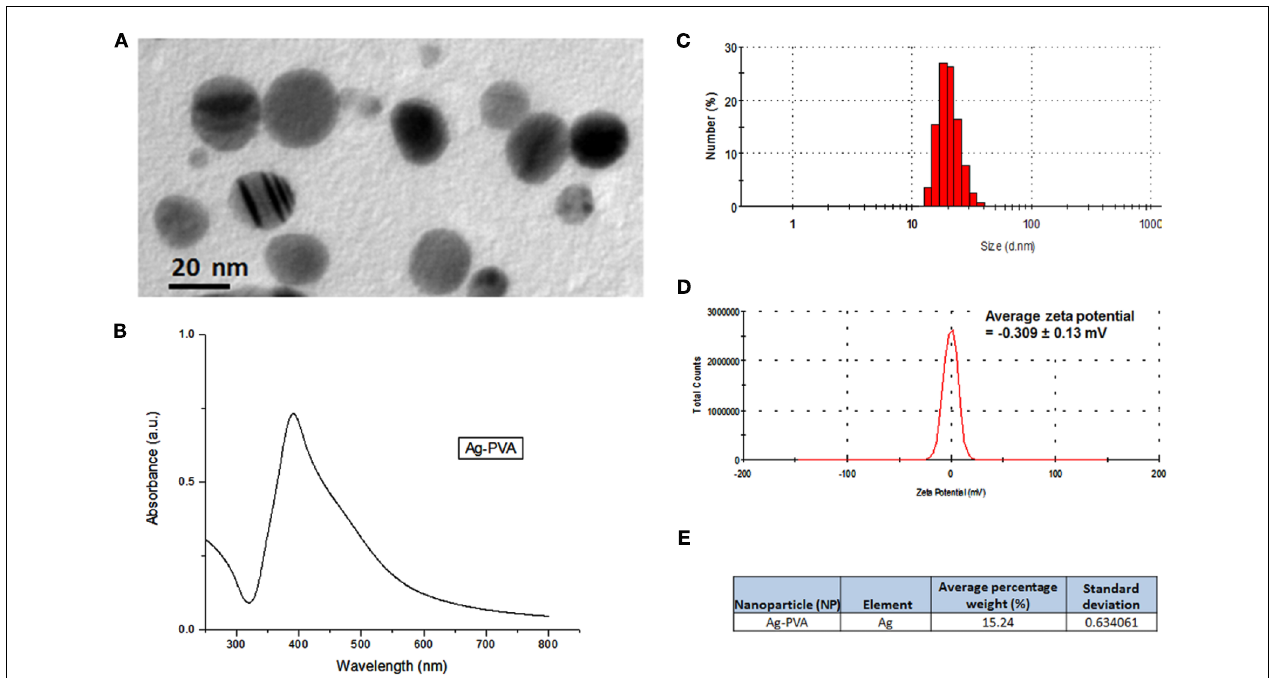
reconstituted after lyophilization.TEM images were captured with JEOL JSM 1220.The size distribution and zeta potential of Ag-np was measured with Zetasizer